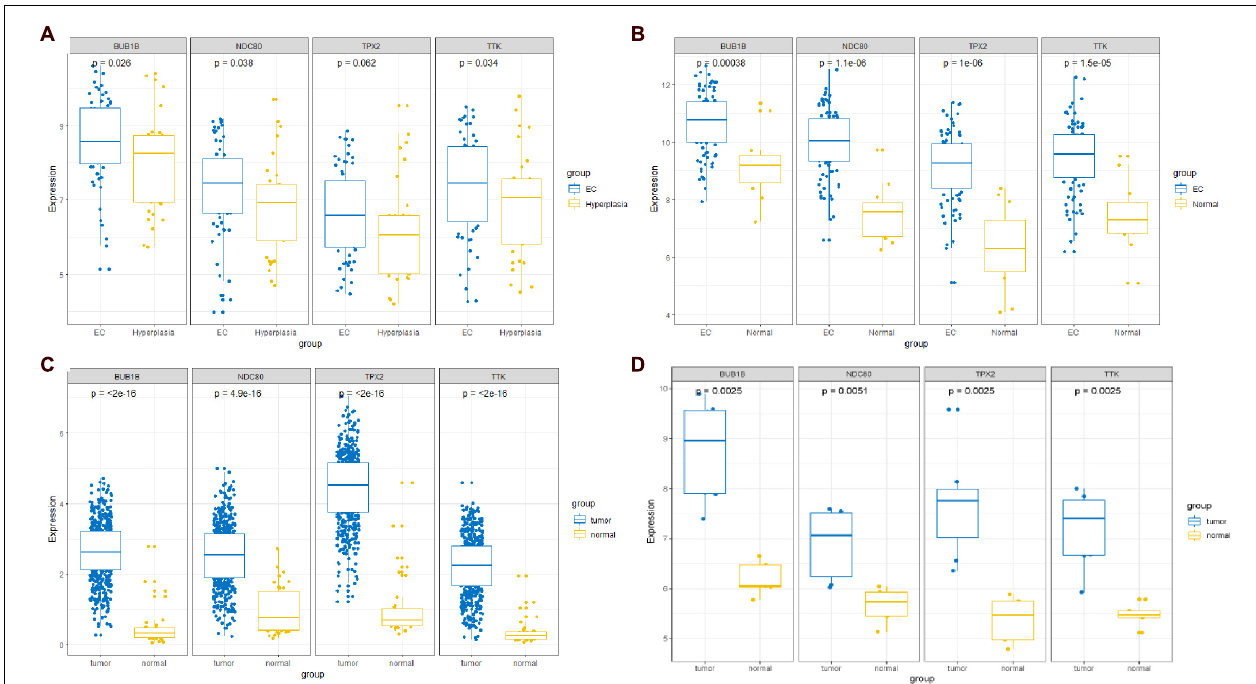
FIGURE 12 | Comparisons of the four-hub gene expression in different datasets between endometrial cancer (EC) and endometrial hyperplasia (EH) or normal tissue. (A) GSE106191 dataset. (B) GSE17025 dataset. (C) UCEC dataset. (D) GSE63678 dataset.